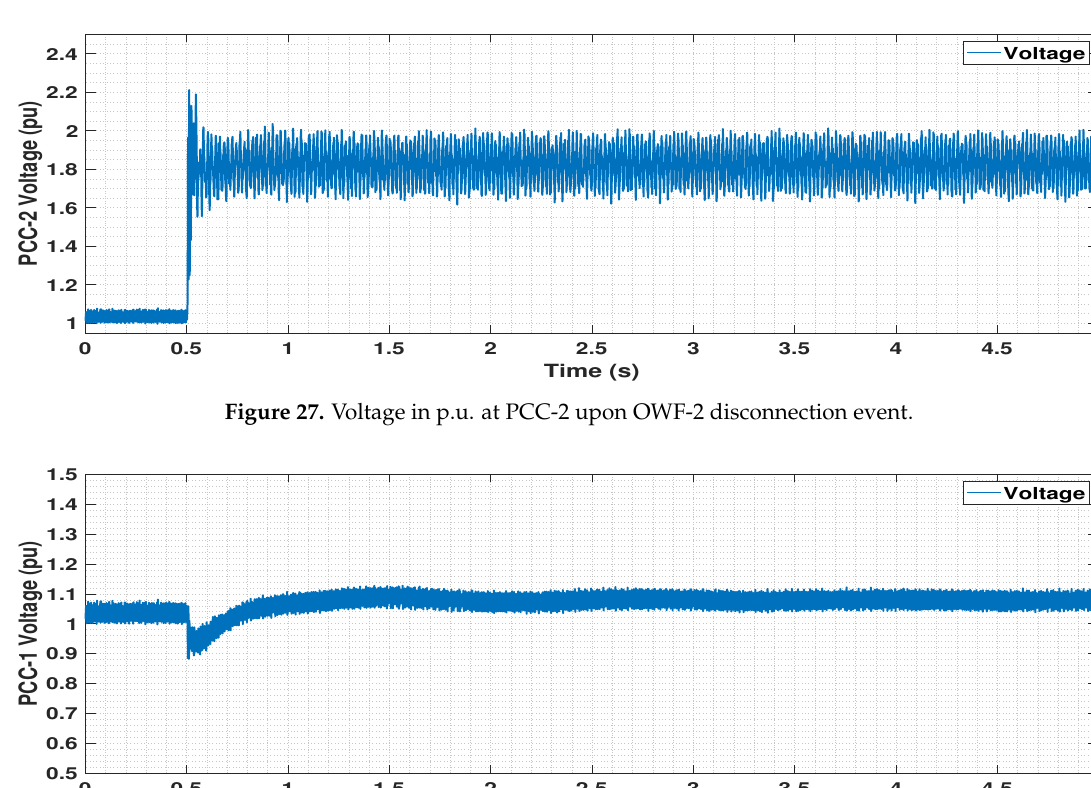
Figure 26. Currents in ( a ) MMC-1 bus and ( b ) MMC-2 bus upon OWF-2 disconnection event. On the OWFs side, the voltage at PCC-2 goes beyond bounds and it has the same value as before energizing. This can be observed from the voltage in p.u. graph in Figure 27. During the disconnection of OWF-2, occurs a drop in voltages at PCC-1, 3 and 4. This is depicted in Figure 28. It happens since they are all connected to a common bus (MMC bus). Moreover, in the post-fault period, voltages at PCC-1, 3 and 4 are stabilized and settle to a higher value (nearly 1.08 p.u.) than the pre-fault voltage in order to compensate for the loss of OWF-2. This is due to the fast local voltage control in the DVC loop of the WGs. But the currents at these OWFs remain the same since the scaling factor for each OWF is still 83 (83 × 6 MW = 498 MW). This can be viewed from the current measured at PCC-1 in Figure 29. As voltage increases and current remains the same, the active power generated from the OWF-1, 3 and 4 increases and therefore the power flowing through MMC-2 also increases.